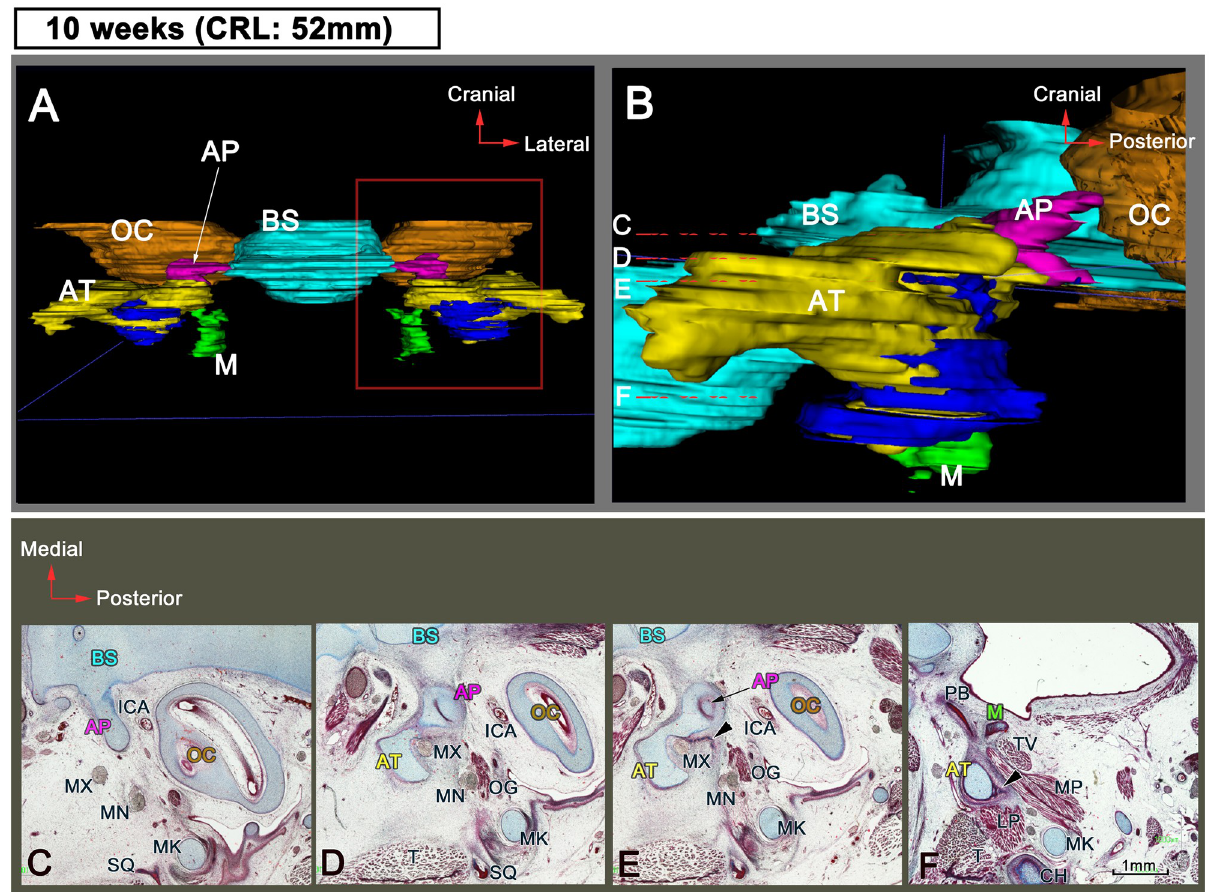
Fig 2. Sphenoid development at 10 WD. (A and B) 3D reconstructions and (C–F) transverse sections. (A) Anterior view and (B) lateral view. Dotted lines (c–f) in (B) correspond to sections in (C–F), respectively. (E and F) Membranous bones around the AT (arrowheads). (C–F) are obtained at the same magnification. Color code: blue, BS; pink, AP; yellow, AT; green, M; orange, OC; dark blue, membranous bones. AP, alar process; AT, ala temporalis; BS, basisphenoid; ICA, internal carotid artery; LP, lateral pterygoid muscle; M, medial pterygoid process; MK, Meckel’s cartilage; MN, mandibular nerve; MX, maxillary nerve; OC, otic capsule; OG, otic ganglion; PB, palatine bone; SQ, squamosal bone; TG, trigeminal ganglion; T, temporalis muscle or temporal bone; TV, tensor veli palatine; WD, weeks of development.